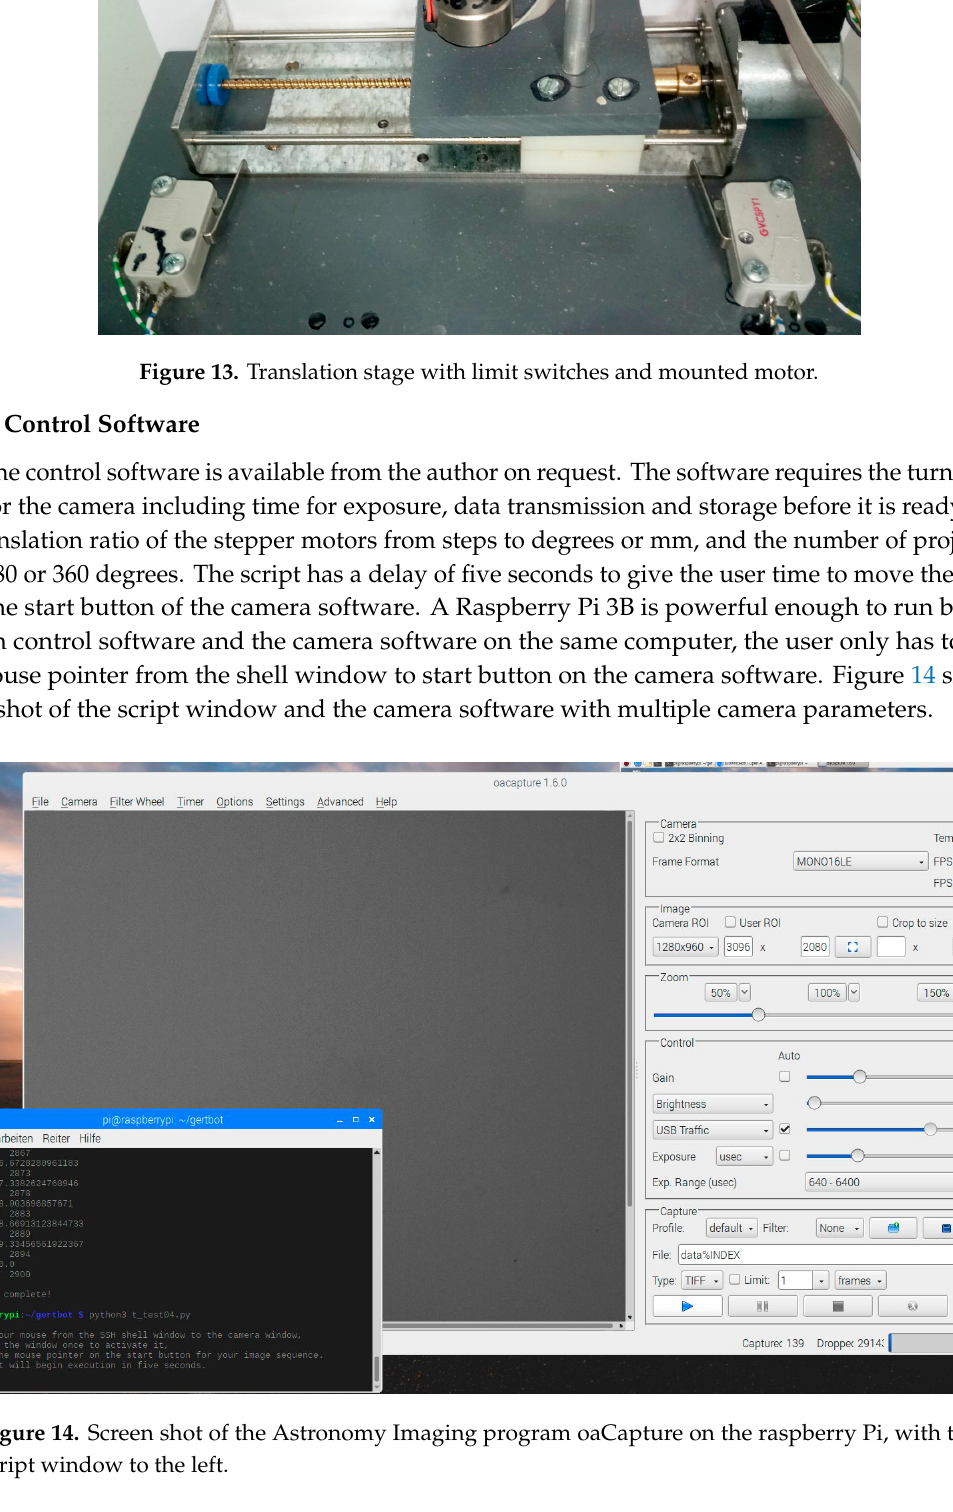
Figure 12. Stepper motor with reduction gear.